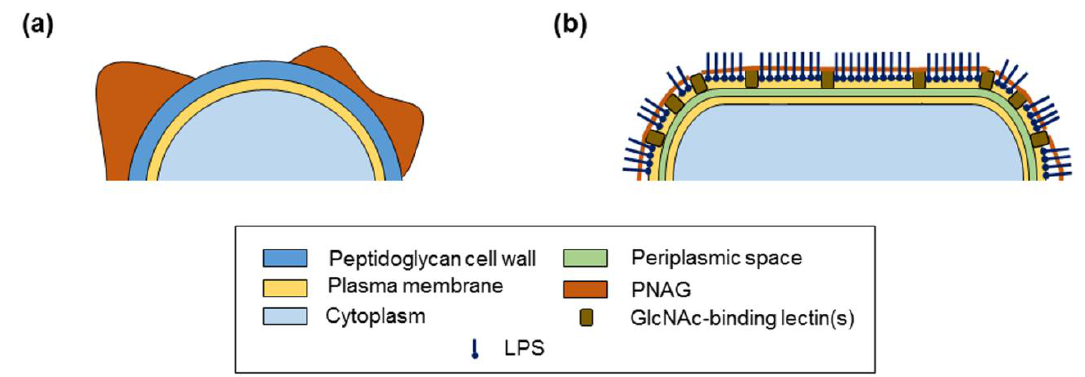
Figure 6. Model of proposed presentation of PNAG on the surface of ( a ) methicillin-sensistive S. aureus , and ( b ) A. baumannii .